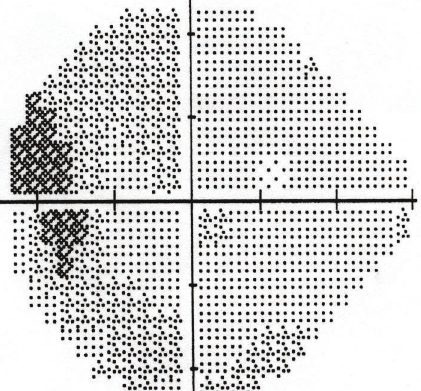
Figure 4: At 1-week postoperative followup, the left eye visual field examination performed with normal stimulus revealed marked